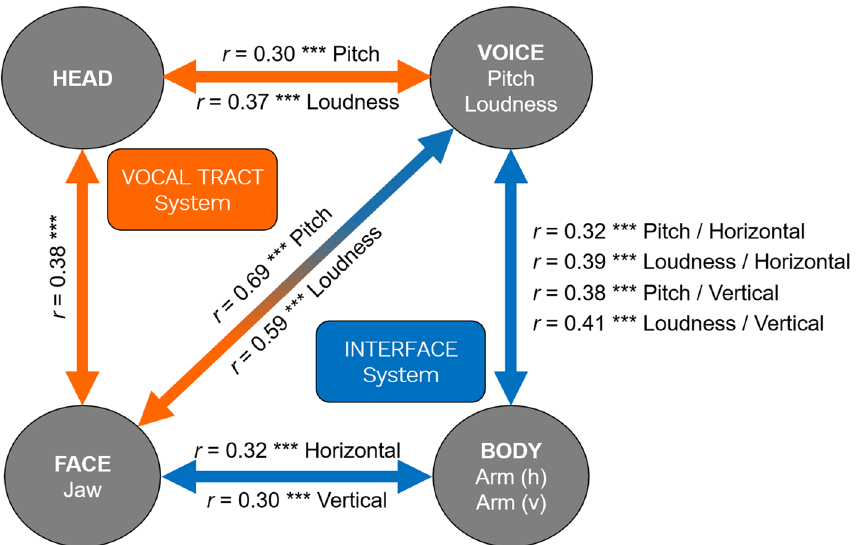
Figure 5. A summary of the major cross-modal correlations . The figure shows the combined correlations of the character and emotion conditions for the parameter means for the head (head raising), voice (increases in pitch and loudness), face (jaw lowering), and body (horizontal and vertical arm expansion). Orange lines represent significant correlations between parameters related to the “vocal tract system”. Blue lines represent significant correlations between parameters related to the “interface system”. Pearson product-moment correlation values are given for each correlation pairing. *** p CORR < .001. See Table 3 for full character and emotion correlations. Note: Pearson product-moment correlations between the Head and Body are r = 0.17 * for vertical arm raising and r = 0.15 n.s. for horizontal arm expansion, respectively. Abbreviations: (h), horizontal; (v),